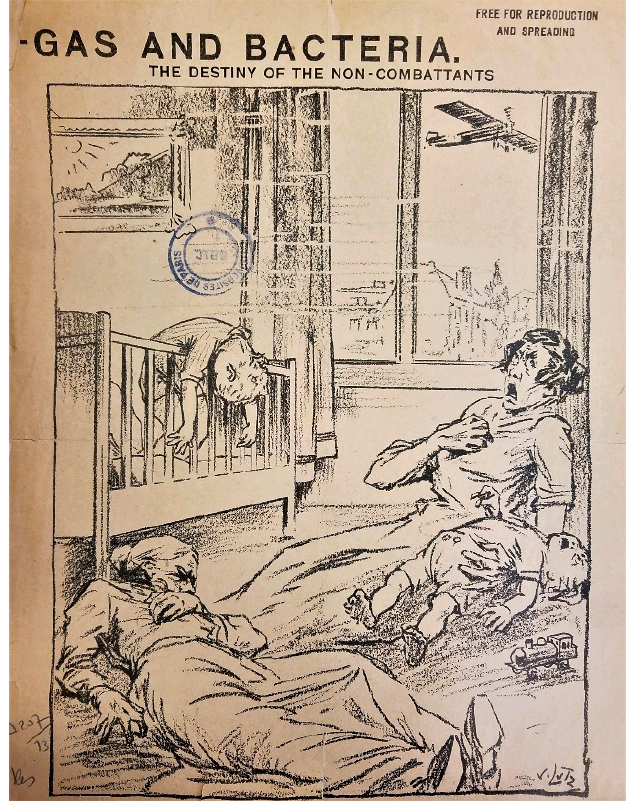
Figure 14. “Gas and Bacteria the Destiny of the Non-Combatants.” 1929. Ink on paper. La Contemporaine. Fonds Duchêne. F Δ res 0207. Box 13. Folder 10.